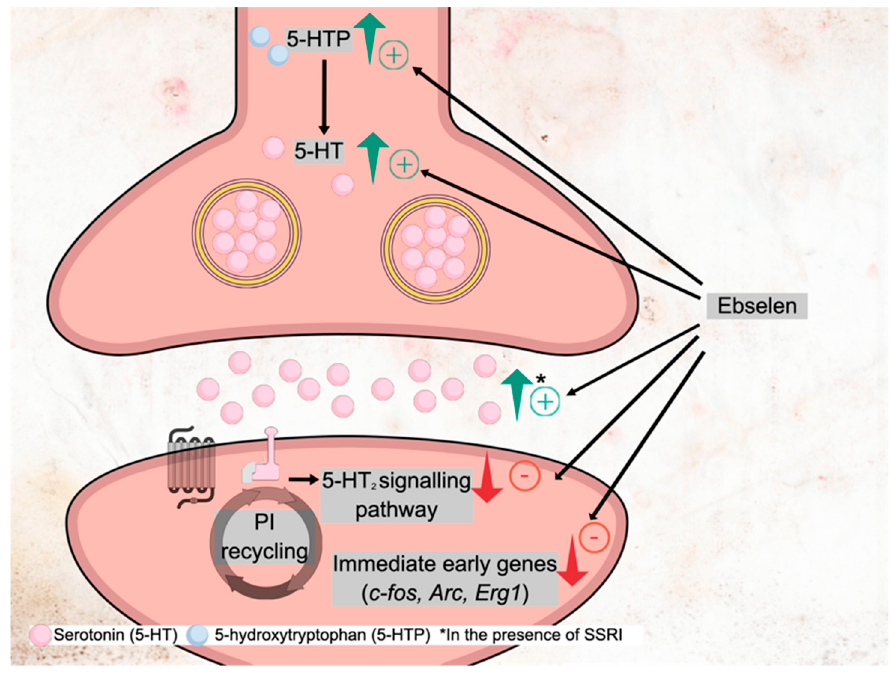
Figure 3. Ebselen effects on serotonergic neurotransmission and neuron.